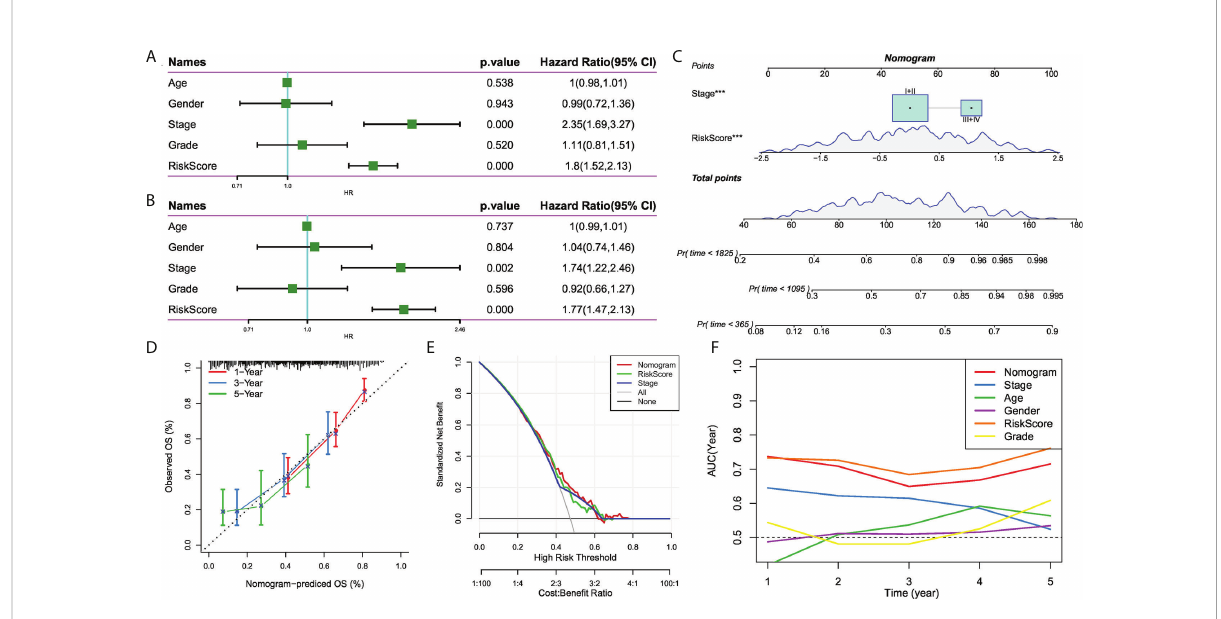
FIGURE 8 The development of a nomogram for predicting the prognosis of HCC. (A, B) Univariate and multivariate Cox analysis of risk score and clinicopathological characteristics; (C) Nomogram model integrating the risk score and stage was constructed; (D) Calibration curves for 1, 3, and 5 years of nomogram; (E) Decision curve for nomogram; (F) Comparison of predictive capacity of clinicopathological features and the nomogram using time-ROC analysis. ***P <